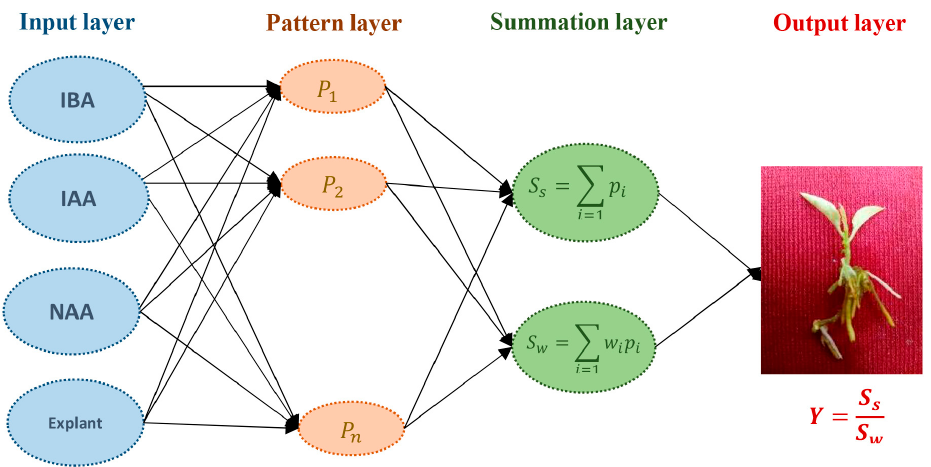
Figure 3. Schematic representation of generalized regression neural network (GRNN) algorithm.